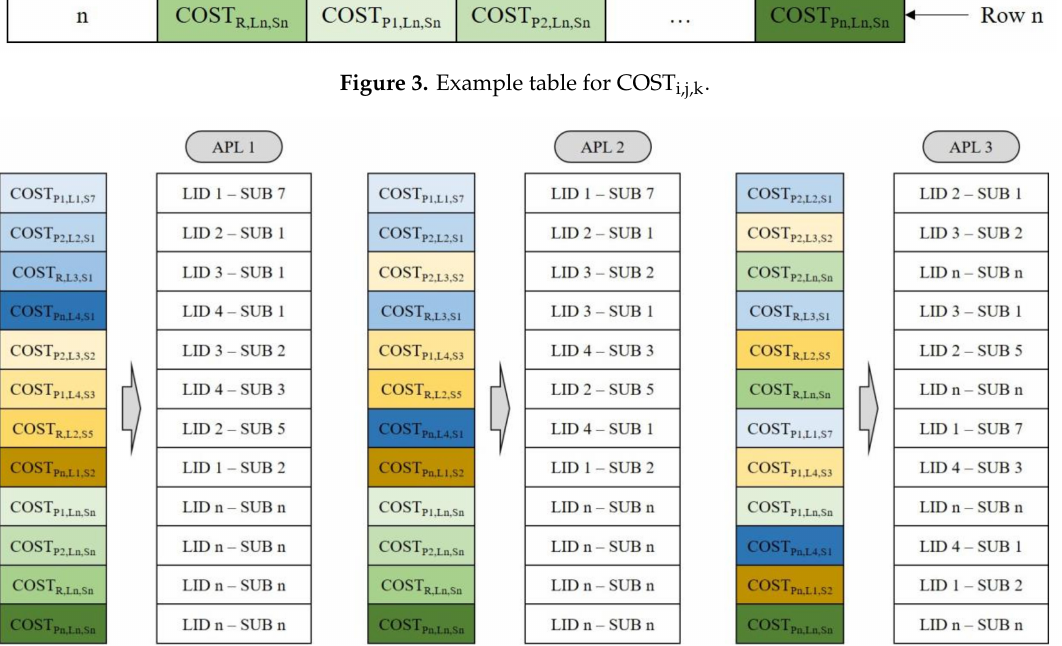
Figure 4. Example of